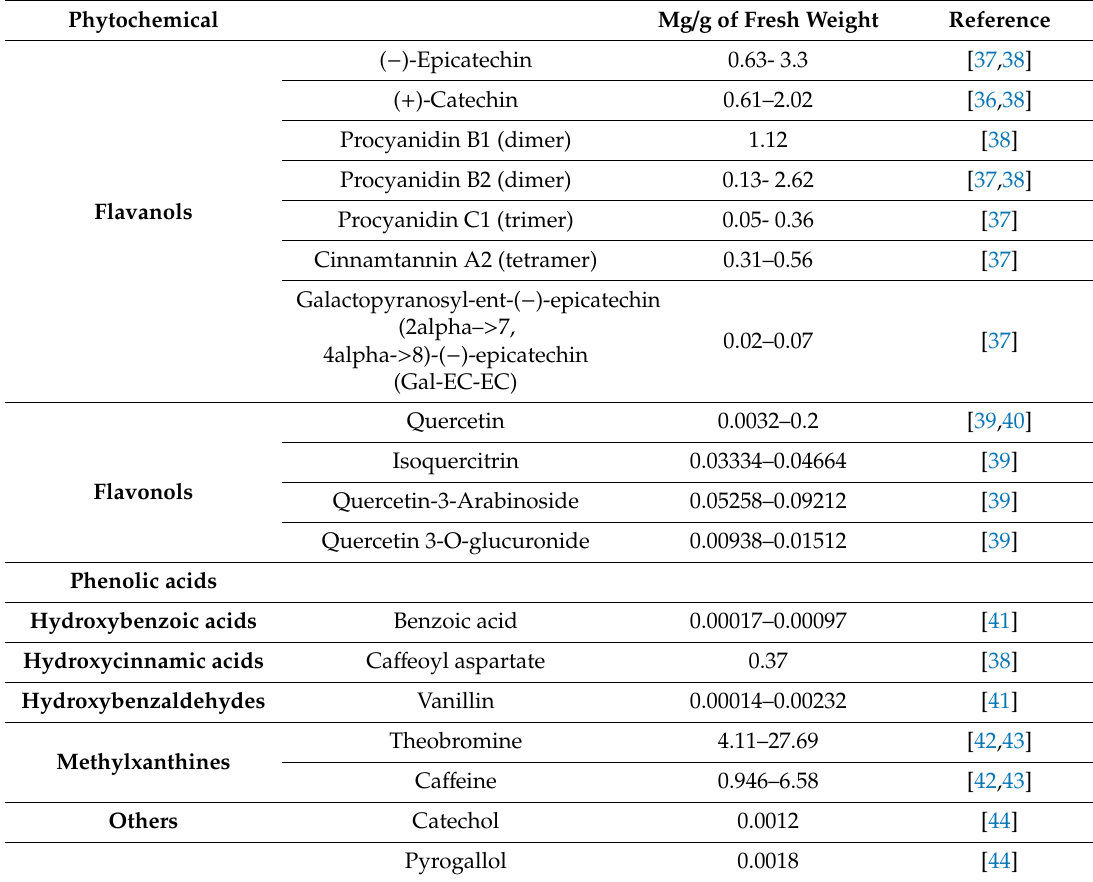
Table 1. Phytochemicals’ concentrations in cocoa